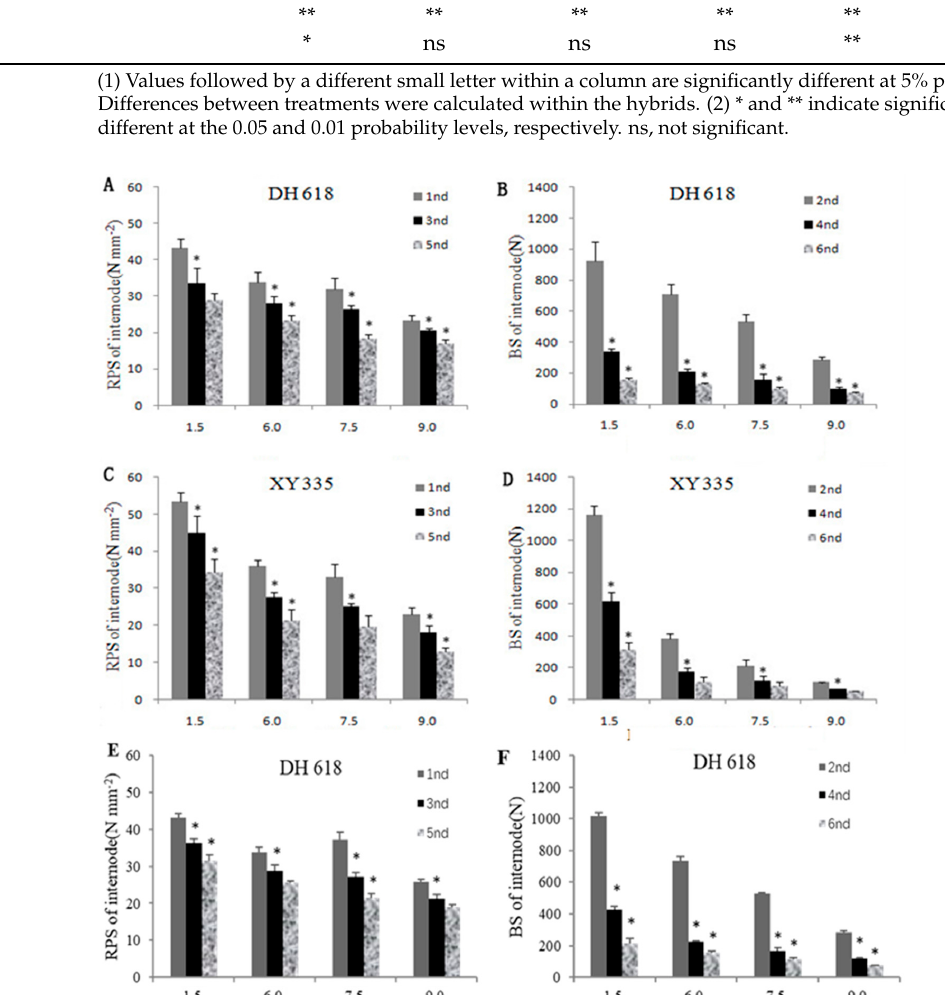
Figure 3. Stalk mechanical strength of DH618 and XY335 at VT + 35d. ( A ) RPS of internode for DH618 under different planting densities in 2014. ( B ) BS of internode for DH618 under different planting densities in 2014. ( C ) RPS of internode for XY335 under different planting densities in 2014. ( D ) BS of internode for XY335 under different planting densities in 2014. ( E ) RPS of internode for DH618 under different planting densities in 2016. ( F ) BS of internode for DH618 under different planting densities in 2016. ( G ) RPS of internode for XY335 under different planting densities in 2016. ( H ) BS of internode for XY335 under different planting densities in 2016. * Significant difference at p < 0.05.